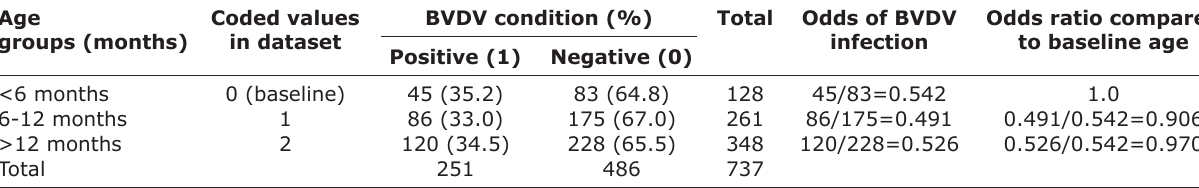
Table-2: Chi-square test for the association between BVD prevalence and age. Age Coded values groups (months) in dataset